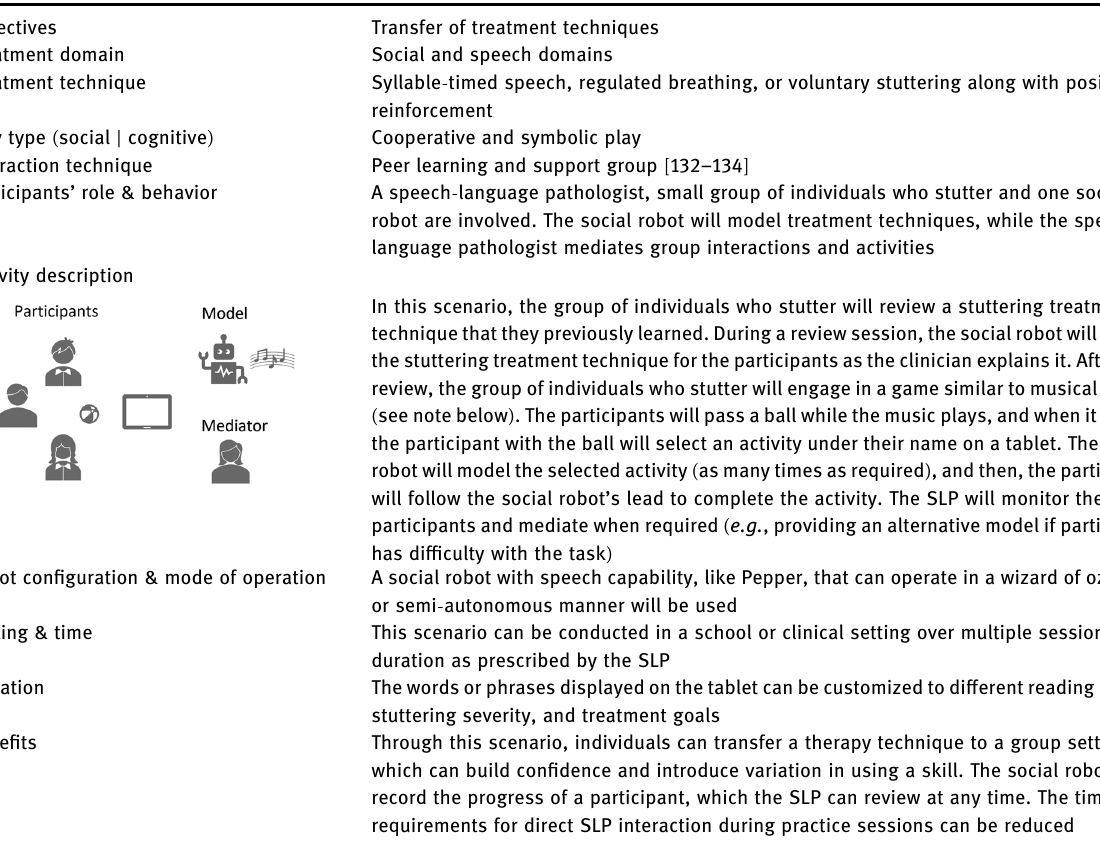
Table 2: Description of scenario 2 Scenario 2: Musical